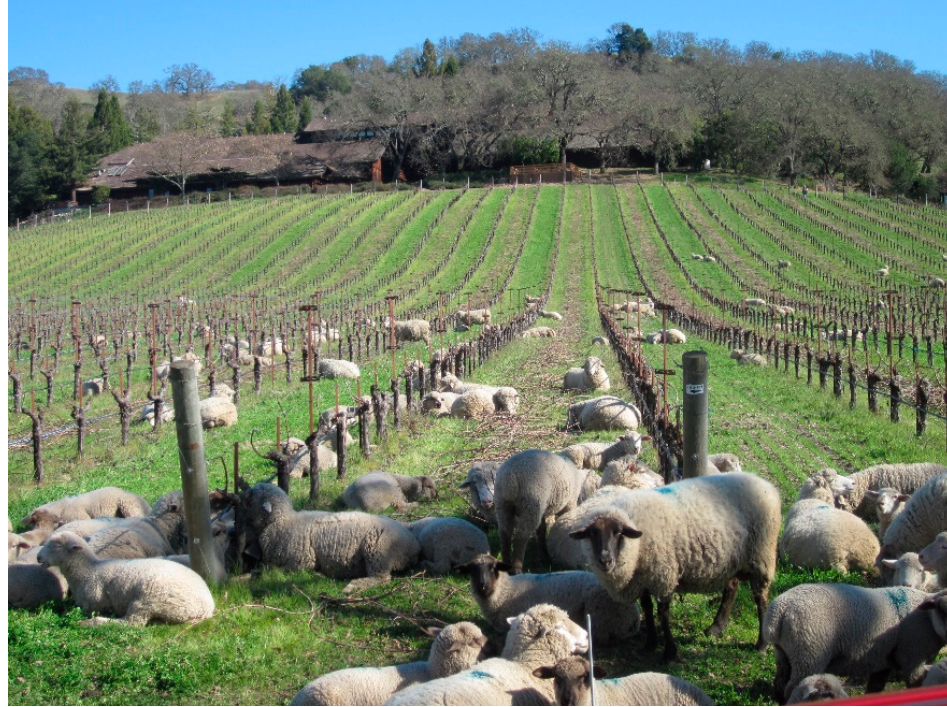
Figure 2. Sheep grazing on winter ground covers in a vineyard during the early spring.